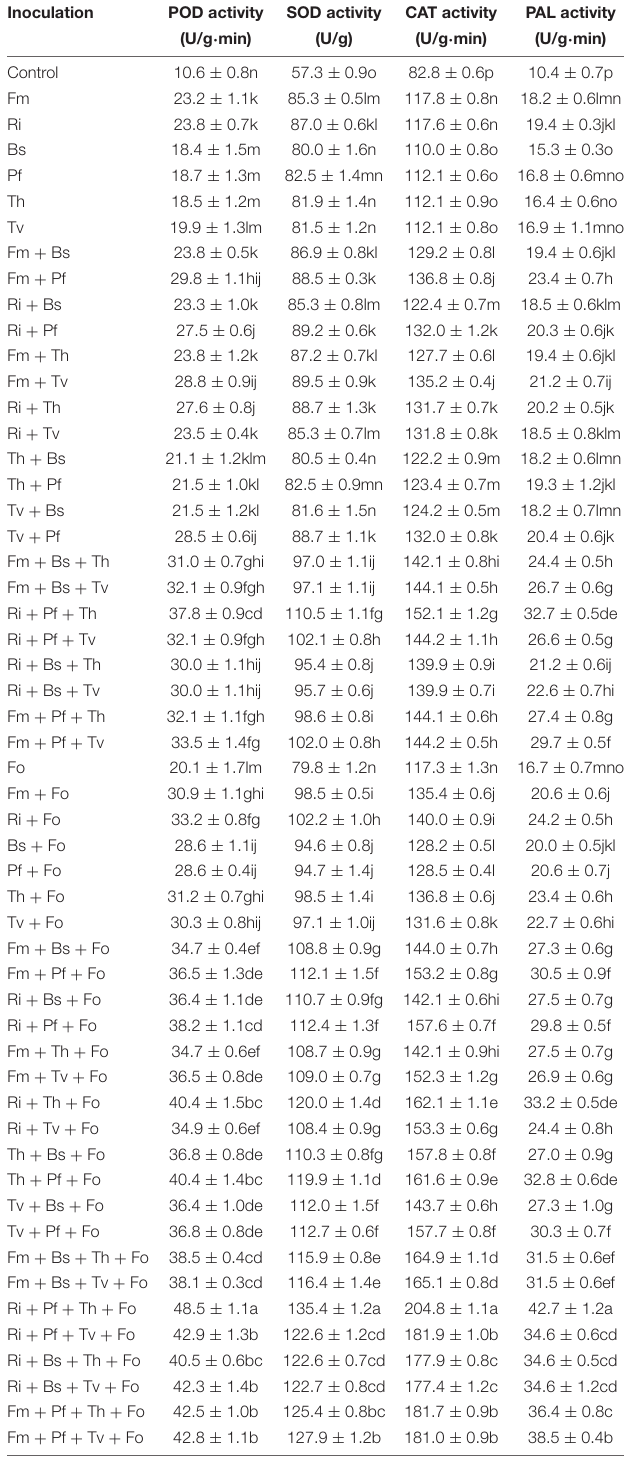
TABLE 5 | Influences of AMF, PGPR, Trichoderma , and Fusarium oxysporum f. sp. radicis-lycopersici on the antioxidant enzyme activity in tomato